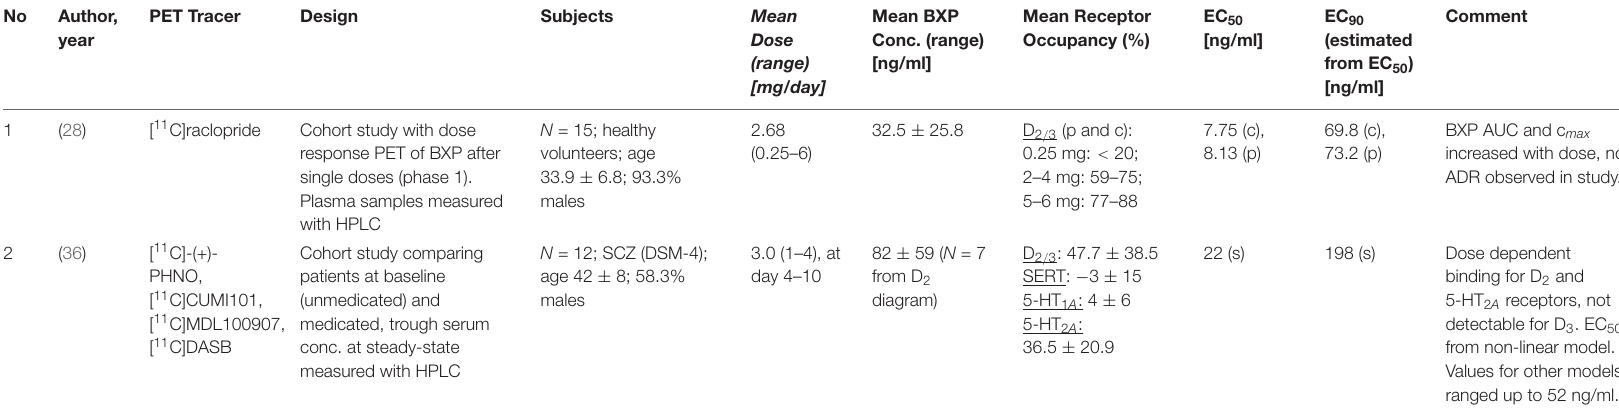
TABLE 2 | PET studies reporting D 2 receptor occupancy and brexpiprazole (BXP) blood concentrations.